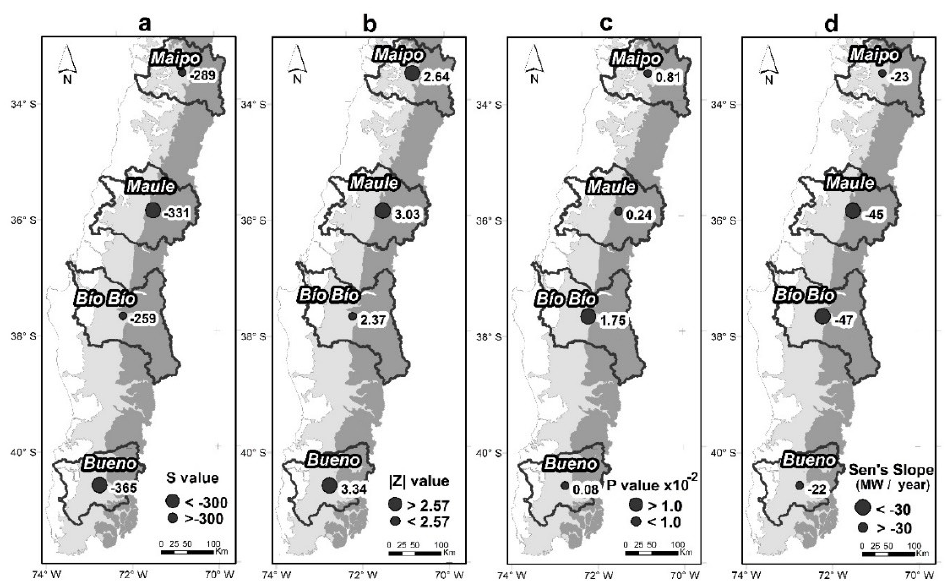
Figure 7. Hydropower trends in the four study basins. S value ( a ), Z values ( b ), p -values ( c ), and Sen’s slope ( d ).